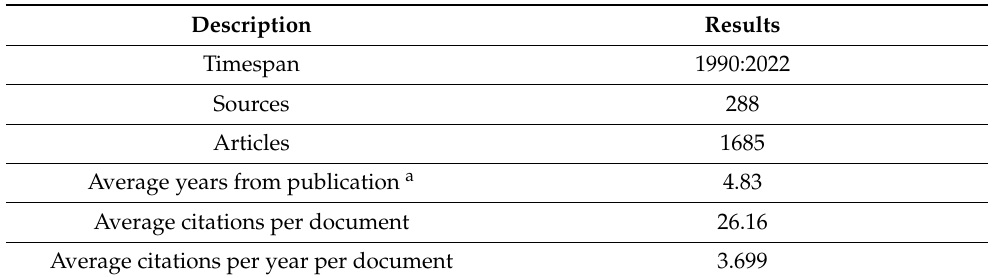
Table 2. Main information from sample 1. Source: own study using data from